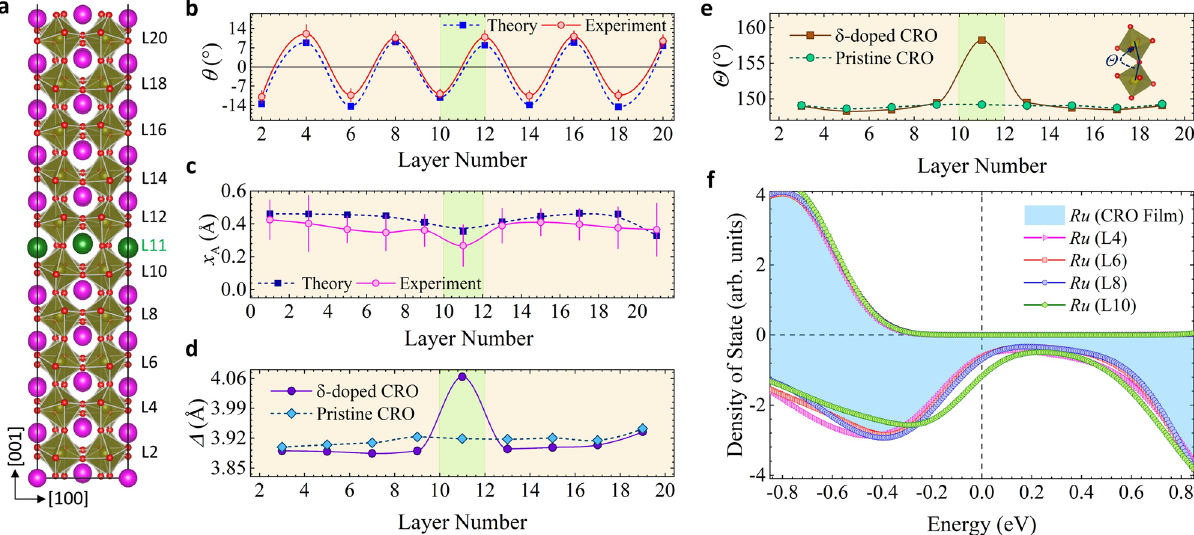
Fig. 5 Density functional theory calculations of δ -doped heterostructure. a Schematic representation of δ -doped heterostructures, where one of the Ca atomic (purple) layers is replaced by Sr atoms (green). b Theoretical and experimental projected octahedral tilt angle ( θ ), and c A-site cation displacement ( x A ). The experimental error-bar in panels b , c is standard deviation of averaged measurement. d Calculated RuO 2 interlayer spacing ( Δ ), and e three-dimensional octahedron bond angle ( Θ ). f Layer-by-layer Ru-projected DOS of the heterostructure, with the selected layers labeled as in panel a . Up-spins (majority) are represented as positive and down spins (minority) as